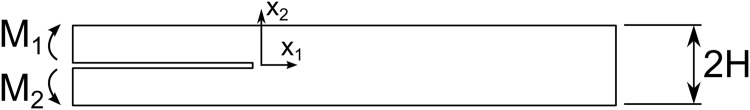
Homogeneous mixed mode specimen scheme.